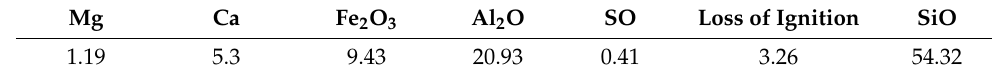
Table 4. Performance index of sand.